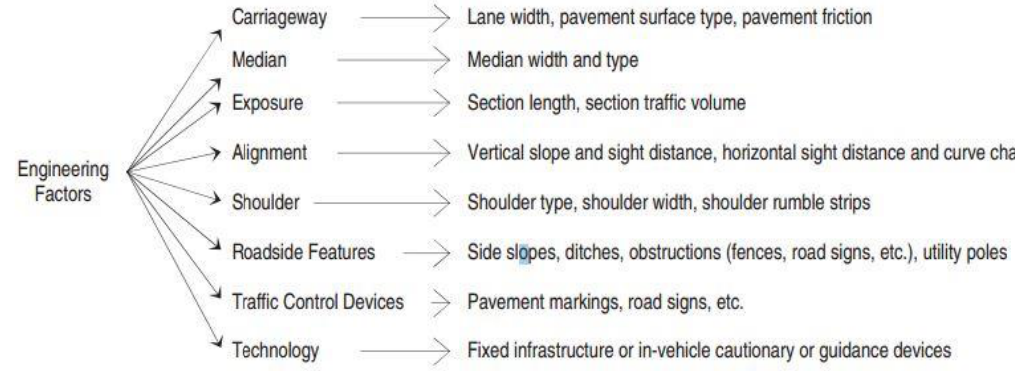
Figure 4: Engineering Factors of Highway Transportation Crashes